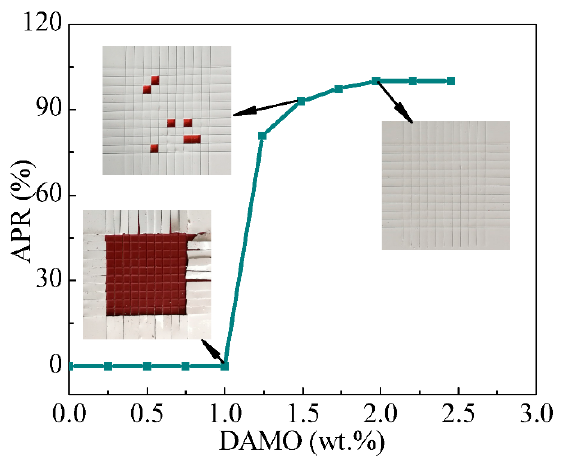
Figure 6. Effect of the DAMO content on the APR of the tie-coating on epoxy primer.